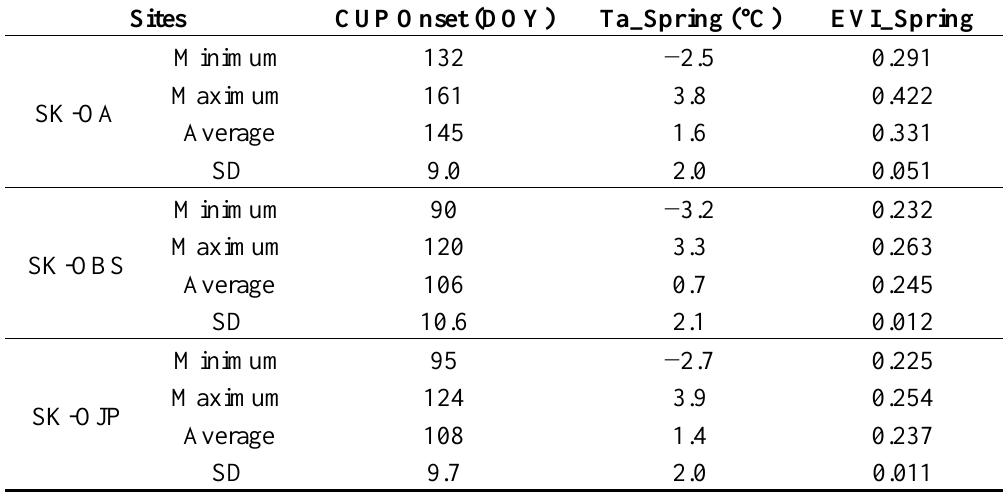
Table 1. Comparison of the three phenological indicators for all sites in this study. Sites CUP Onset (DOY) Ta_Spring (°C) EVI_Spring Minimum 132 −2.5 0.291 Maximum 161 3.8 0.422 SK-OA Average 145 1.6 0.331 SD 9.0 2.0 0.051 Minimum 90 −3.2 0.232 Maximum 120 3.3 0.263 SK-OBS Average 106 0.7 0.245 SD 10.6 2.1 0.012 Minimum 95 −2.7 0.225 Maximum 124 3.9 0.254 SK-OJP Average 108 1.4 0.237 SD 9.7 2.0